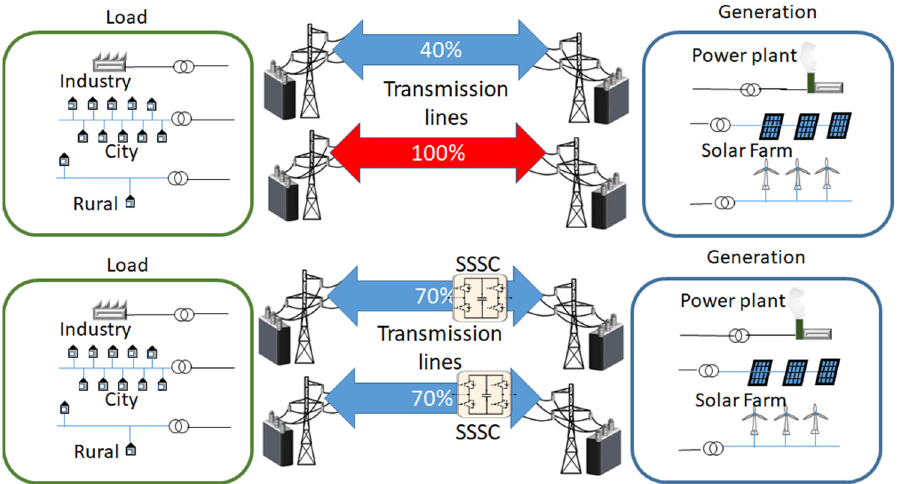
Figure 2. The unbalance in the transmission power lines can be compensated with TSB-SSSC.